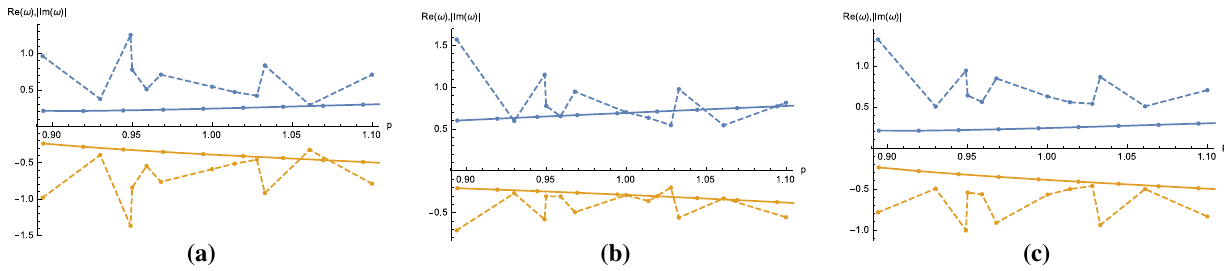
Fig. 1 The fundamental quasinormal mode ( n = 0) for the scalar field ( s = 0), blue line is real part of frequencies, red line is imaginary part; dashed lines are the data obtained in the work [23], positive values for the real part and negative values for the imaginary part: a l = 0; b l = 1; c l = 2